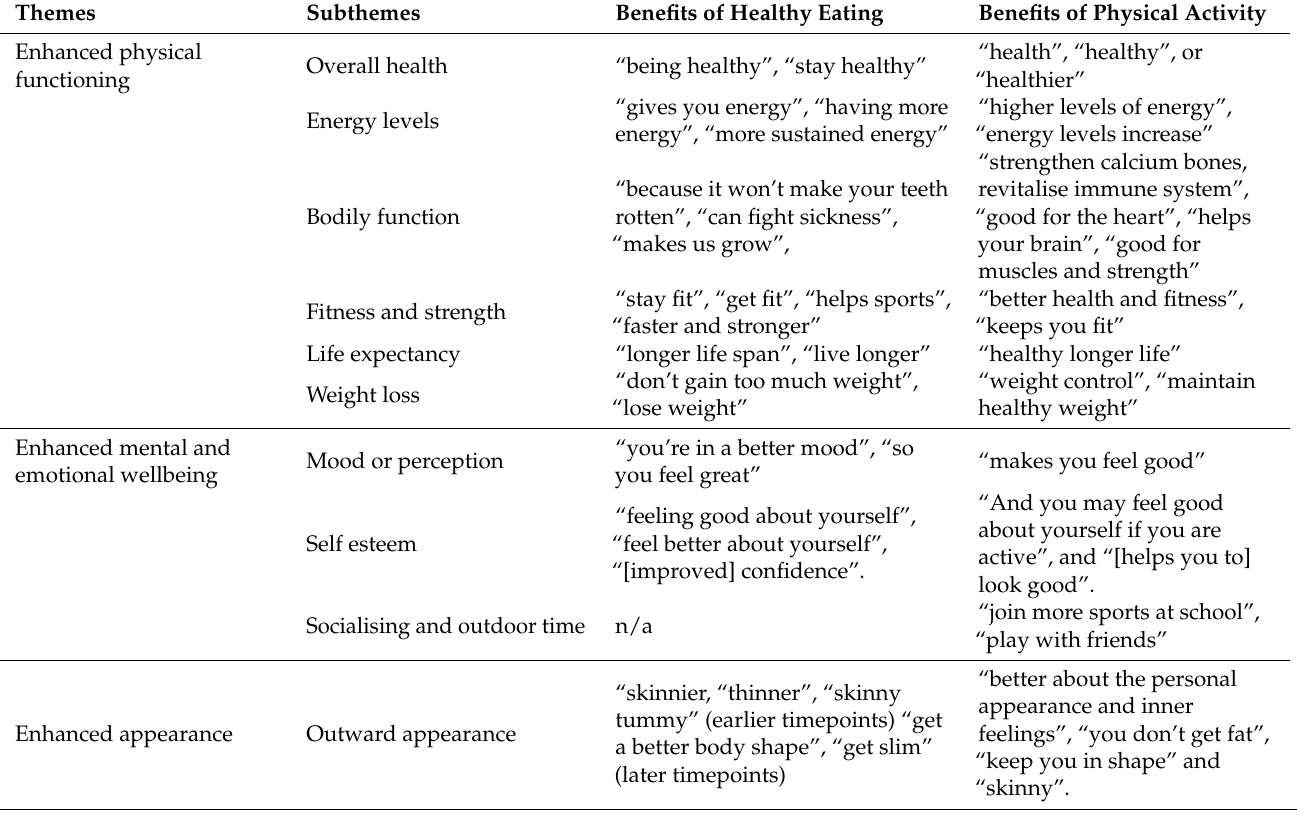
Table 4 outlines themes and subthemes identified from open-text questions relating to the benefits of healthy eating and physical activity in the health beliefs questionnaire. Table 4. Themes and subthemes identified from open-ended questions in the Wh¯anau Pakari cohort, and respective examples as provided by study